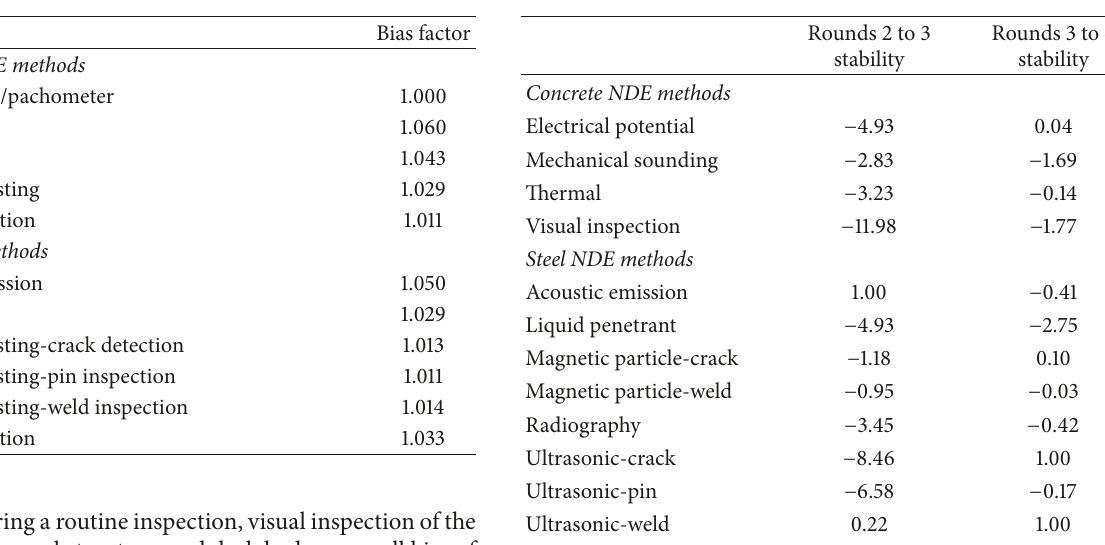
Table 3: Concrete and steel NDE method bias factor determined from the participant responses.